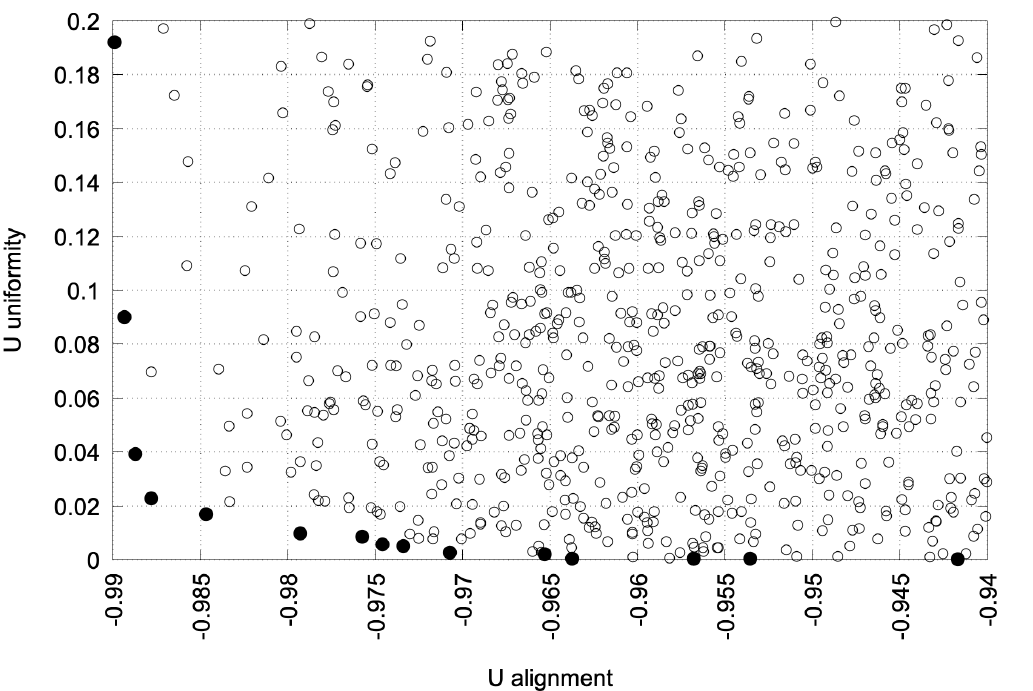
Figure 7. Pareto front for the multi-objective optimization problem of the JBC containership. Black dots are representing the computed Pareto front, white dots are indicating other tentative